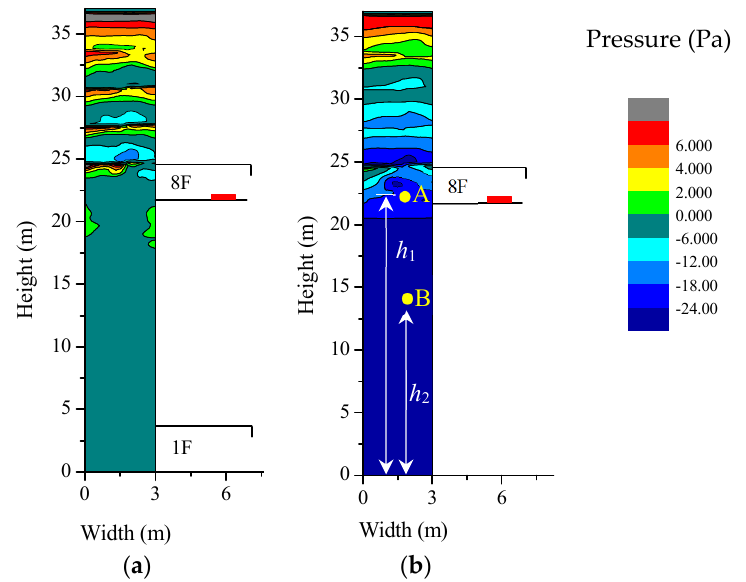
Figure 5. Pressure difference distributions in the staircase at 0 m/s. ( a ) Stair door opened on the first floor. ( b ) Stair doors closed.